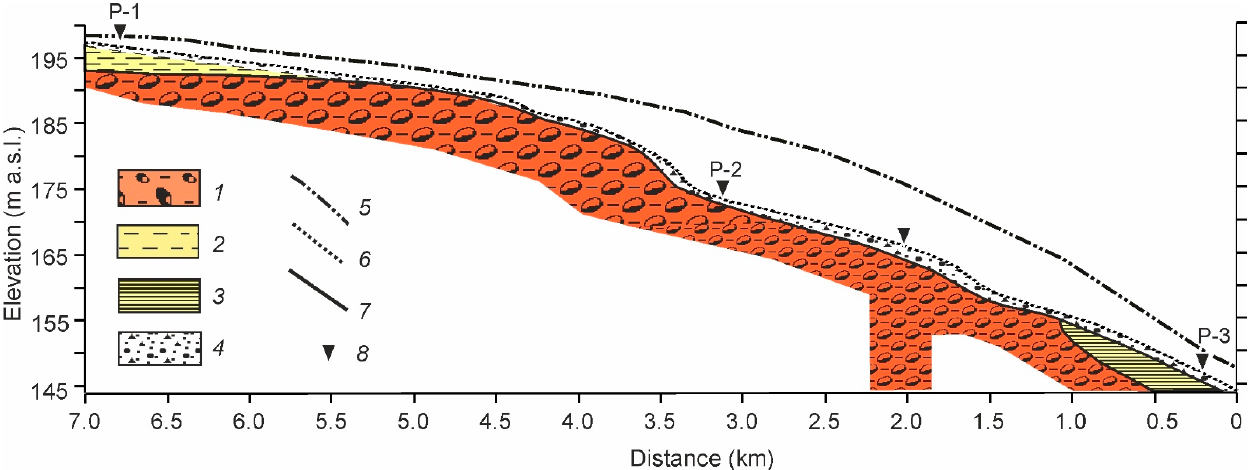
Figure 11. Longitudinal profile of the Cholokhovskaya Balka. Keys: 1—MIS 6 moraine, 2—glaciofluvial or glaciolacustrine silt, 3—MIS 5e deposits, 4—the Holocene deposits (sand and loam), 5—initial slope, 6—gully terrace surface, 7—gully bed, 8—cross-sections with cores.